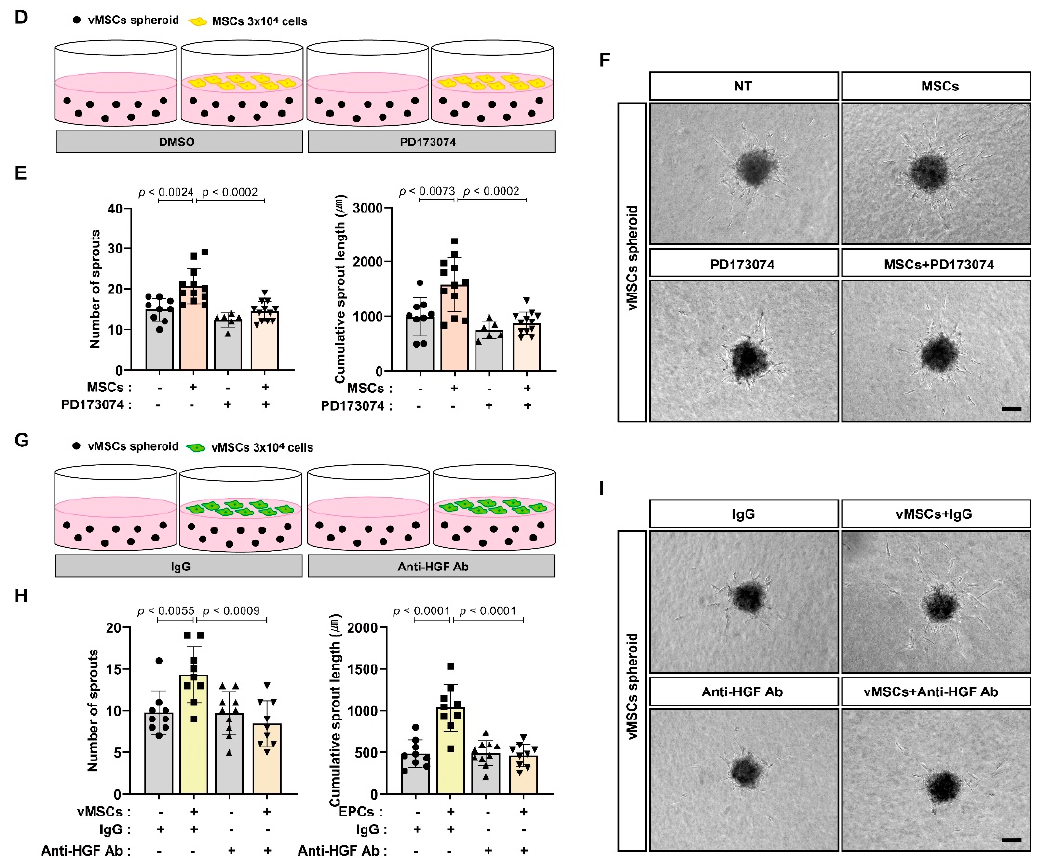
Figure 3. In vitro angiogenic sprouting of vMSCs in response to paracrine factors derived from vMSCs and MSCs. ( A-C ) Sprouting capacity of vMSC spheroids co-cultured with vMSCs, MSCs or hDF for 48 h. Schematic representation in ( A ) and representative images in ( C ). ( D-F ) Sprouting capacity of vMSC spheroids pretreated with PD173074 (10 nM) for 3 h followed by co-culture with MSCs for 48 h. Schematic representation in ( D ) and representative images in ( F ). ( G-I ) Sprouting capacity of vMSC spheroids pretreated with vMSCs and/or HGF neutralizing antibody (anti-HGF Ab, 500 ng/mL) for 48 h. Mouse IgG (IgG, 500 ng/mL) was used as the control. Schematic representation in ( G ) and representative images in ( I ). Results are presented as the mean ± SD. n.s.; not significant. Scale bar; 100 μ m.